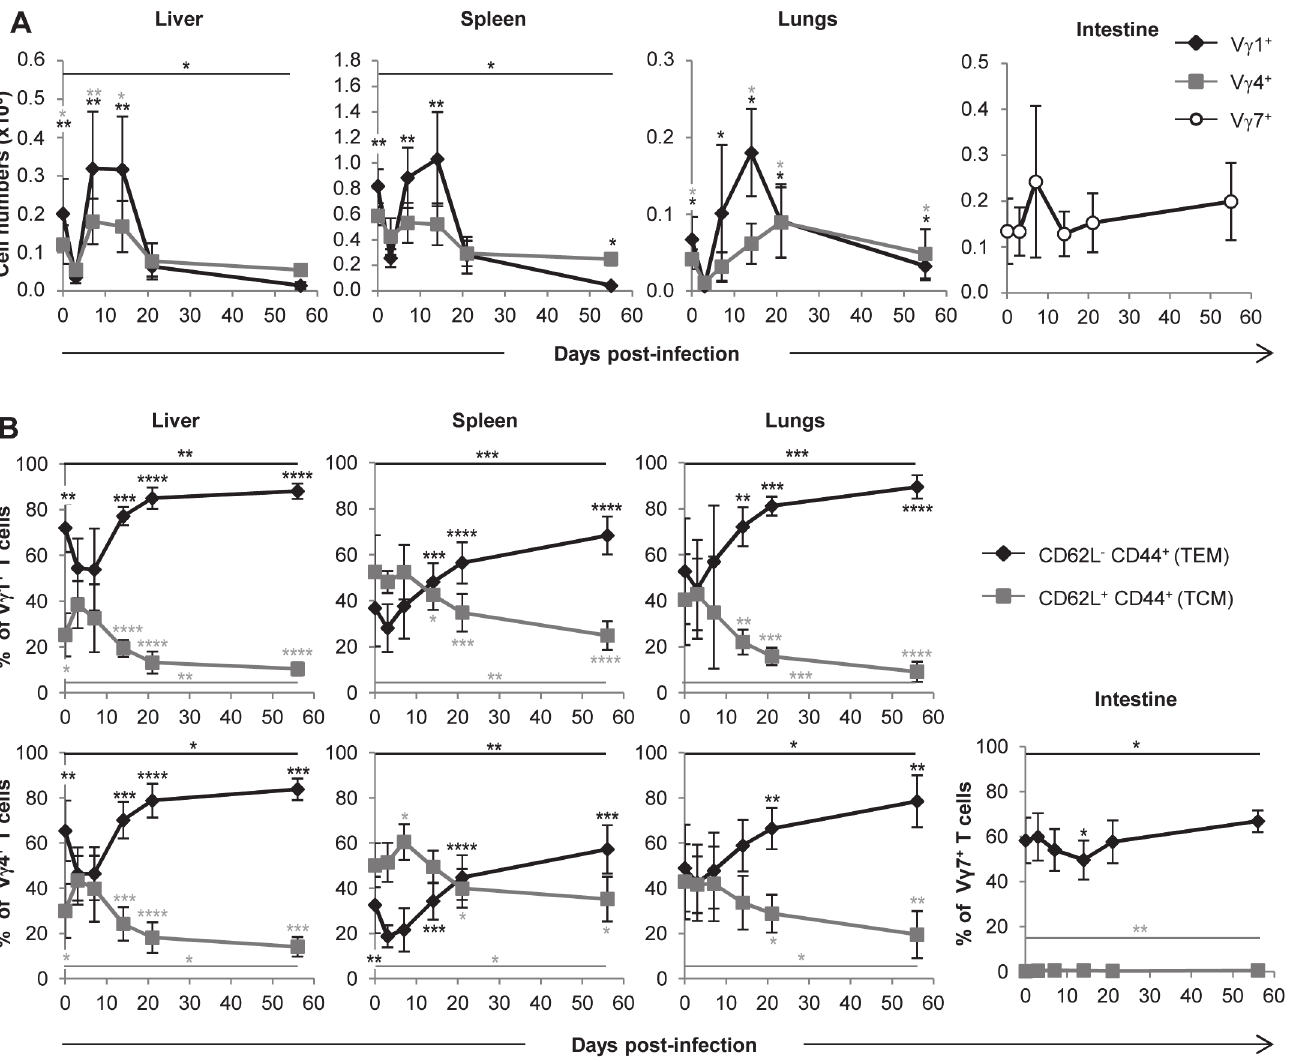
Fig 5. Both V γ 1 and V γ 4 subset are involved in γδ T cell response to MCMV. TCR α − / − mice were infected i.p. with 2.10 3 PFU of MCMV. At indicated days post-infection, 5 – 9 mice were sacrificed and immune cells were prepared from each organ. Expression of V γ 1, V γ 4 and V γ 7 chains by lymphocytes was evaluated by flow cytometry (S2 Fig.). A. Kinetics of absolute cell numbers for each subset. Presented data are mean ± SEM of 8 – 9 mice from one representative of 2 experiments. B . CD62L and CD44 expression by γδ T cell subsets was evaluated by flow cytometry in all organs. Results are pooled from 2 independent experiments representing a total of 13 – 14 mice (means ± SEM). Statistical differences of cell numbers and percentages between day 3 and other time points are shown, as well as statistical differences between days 0 and 56 (solid